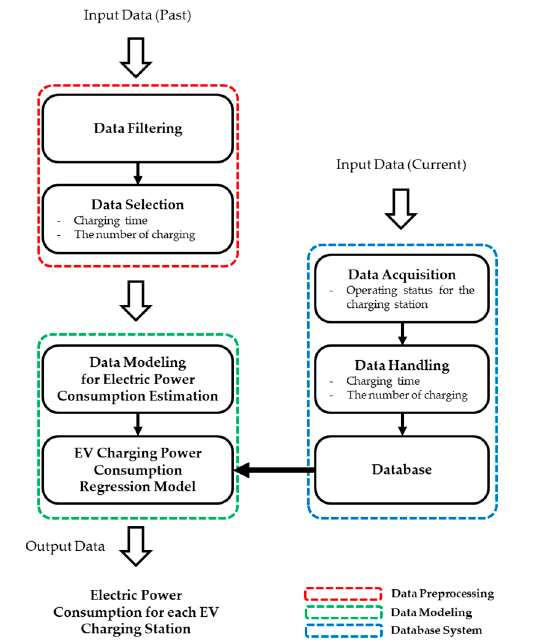
Figure 1. Block Diagram of the proposed system. EV: electric vehicle.